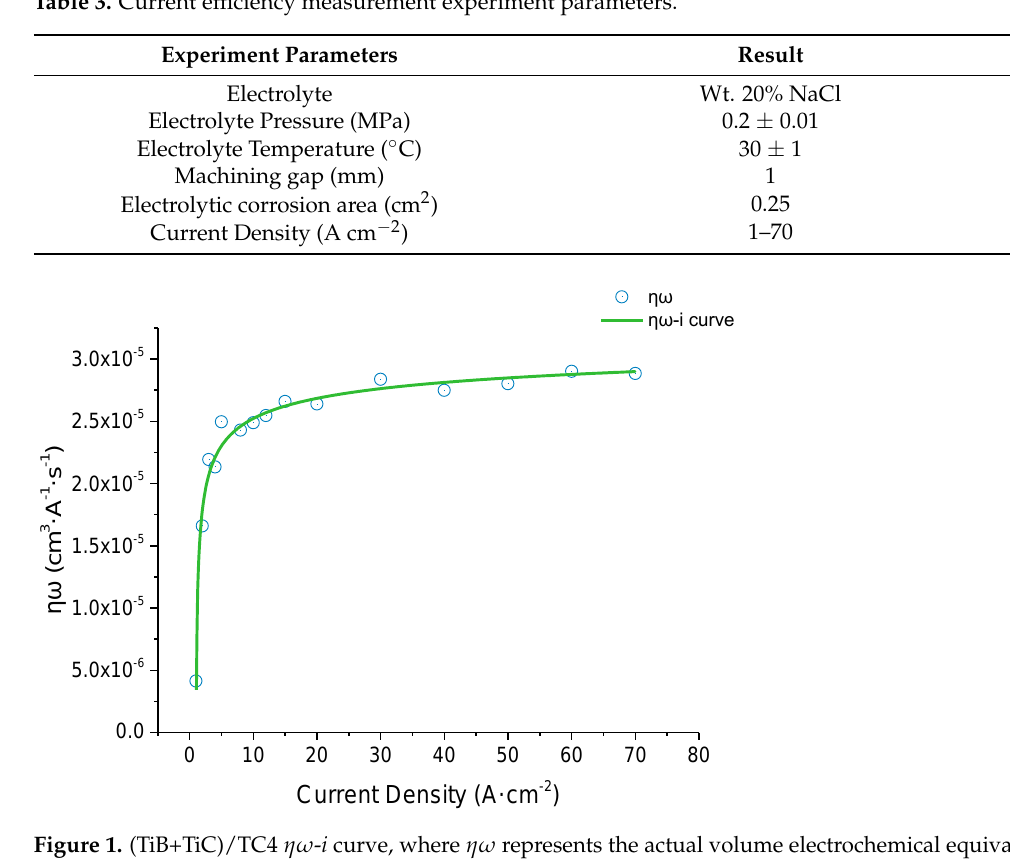
Table 3. Current efficiency measurement experiment parameters .